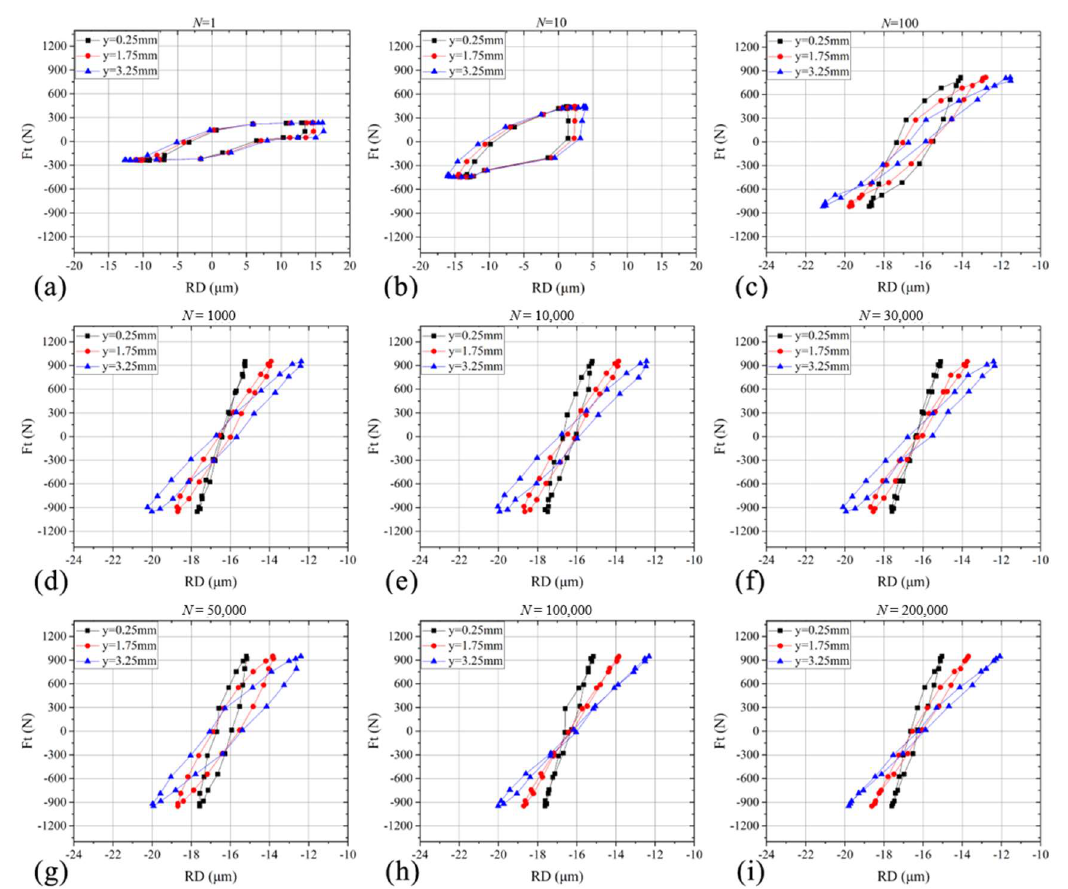
Figure 10. Hysteresis loops of tangential force ( F t) in a function of relative displacement (RD) for the 6.5 kN case: ( a ) N = 1, ( b ) N = 10, ( c ) N = 100, ( d ) N = 1000, ( e ) N = 10,000, ( f ) N = 30,000, ( g ) N = 50,000, ( h ) N = 100,000, and ( i ) N = 200,000.